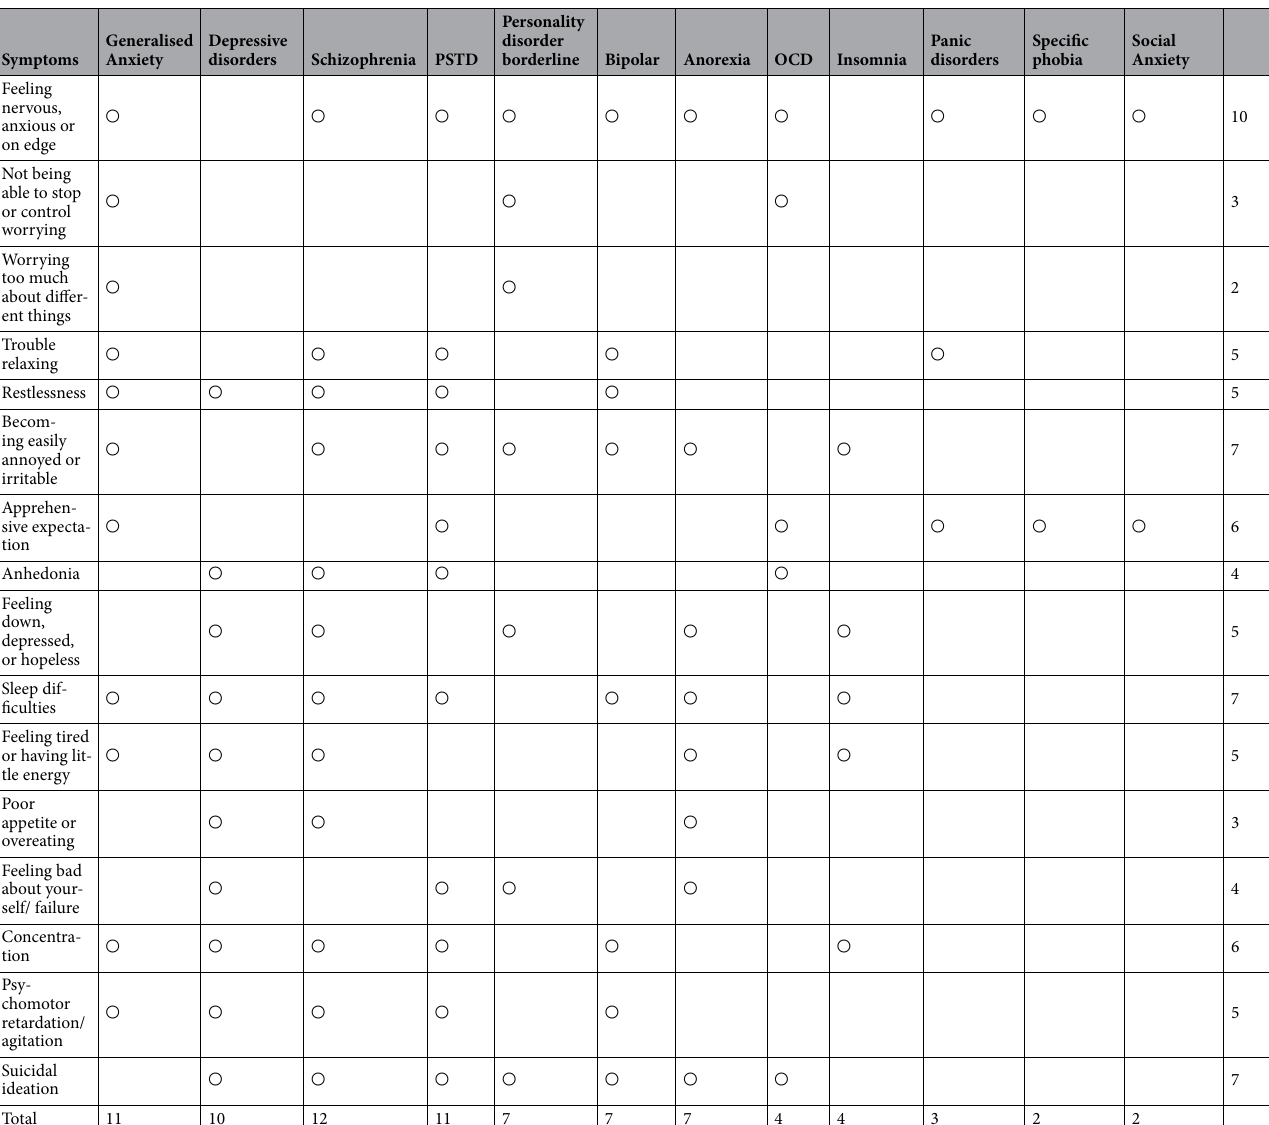
Table 1. Symptoms captured by the PHQ-9 and GAD-7 mapped onto features of DSM-5